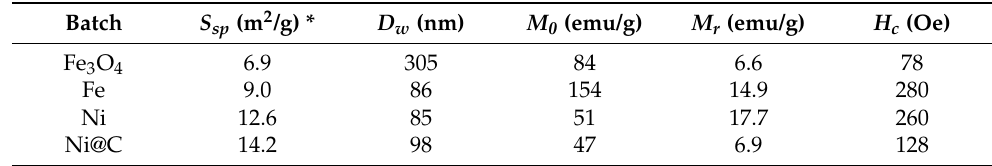
Table 1. Selected properties of magnetic particles used in alginate-based magneto-rheological suspen- sions.